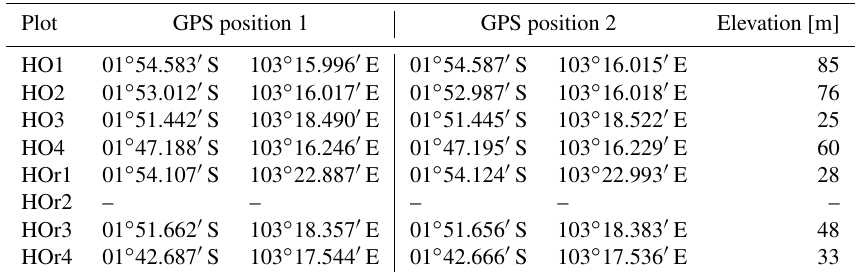
Table A1. Representative elevation transects of topsoil sampling under oil-palm plantations.